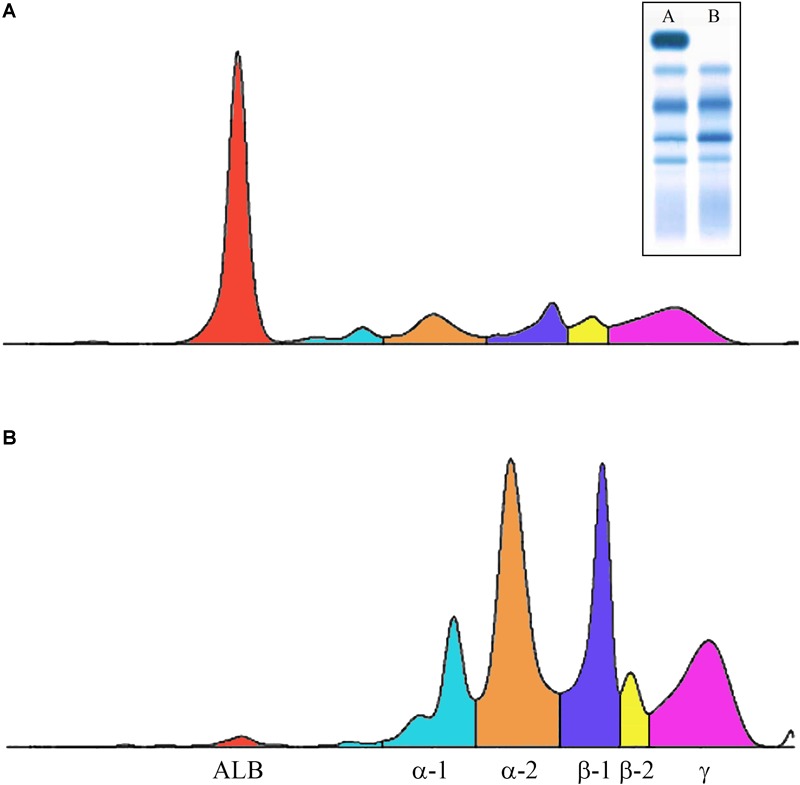
Capillary electrophoresis of serum proteins. The profiles were obtained via the fully automated Helena V8 Capillary Electrophoresis System. (A) Normal; (B) patient having the Erzurum trait (Caridi et al., 2016a). Inset: conventional serum protein electrophoresis (A, normal; B, analbuminemic subject). Both types of electrophoresis allow to detect that in the patient ALB is near absent, whereas all the globulin fractions are increased.